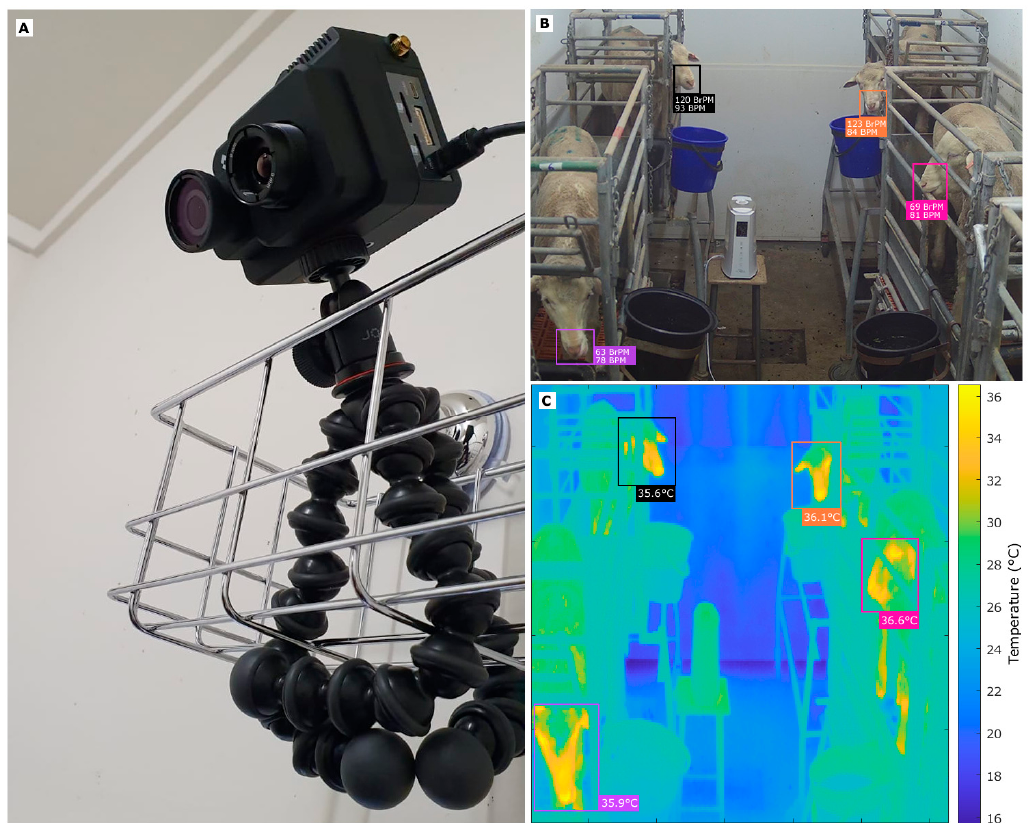
Figure 1. Images showing the experimental layout for thermoneutral (control) and heat stress chambers and implementation of feature tracking algorithms and machine learning (ML) Models 1 and 2 developed, with ( A ) the FLIR ® Dup Pro camera setup, ( B ) shows the selected region of interest (ROI: nose) from each sheep visible and extraction of corresponding respiration rate and heart rate values from the video analysis using machine learning (Models 1 and 2), and ( C ) the selected region of interest (ROI: face) from each sheep and automatic tracking and extraction of temperature values ( ◦ C) from the infrared thermal video (IRTV) analysis. Abbreviations: BrPM: breaths per minute; BPM: beats per minute.